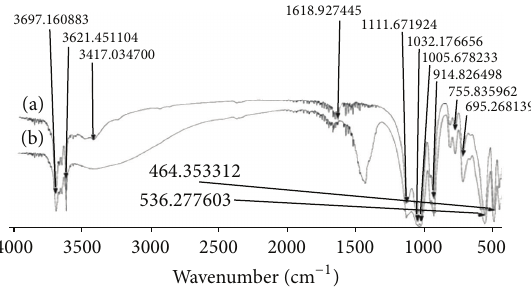
Figure 1: FT-IR spectrum of (a) Kaolin and (b) Kaolin/Ag nanocomposite.